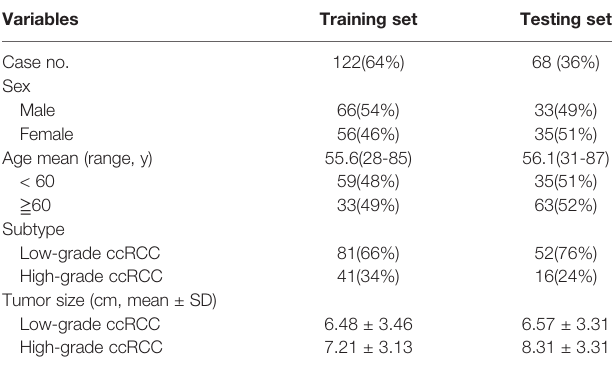
TABLE 1 | Demography of patients in two